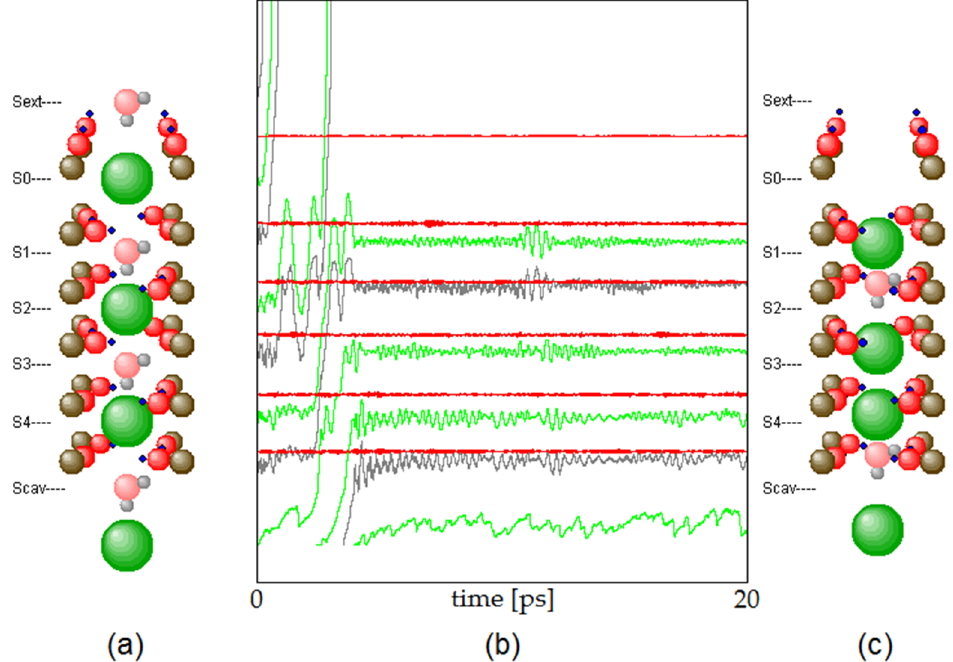
Figure 4. Initial configuration ( a ) and configuration after thermalization within 20 ps ( c ). The graph ( b ) shows the z-component (upwards) of the momentary positions of K + ions (green), H 2 O molecules (grey) and O-atoms (red). Note that two K + and two H 2 O exit the SF on top within the first few ps. Within about the same time, two K + enter below from the cavity region and an H 2 O and a K + enter the site S cav from the cavity, ready to enter the SF as soon as the particles at higher position move upwards. The vibrational amplitude of the O-atoms is relatively small due to the stiffness and corresponding high frequency of the C=O bond (wavenumber around 500 cm − 1 ).